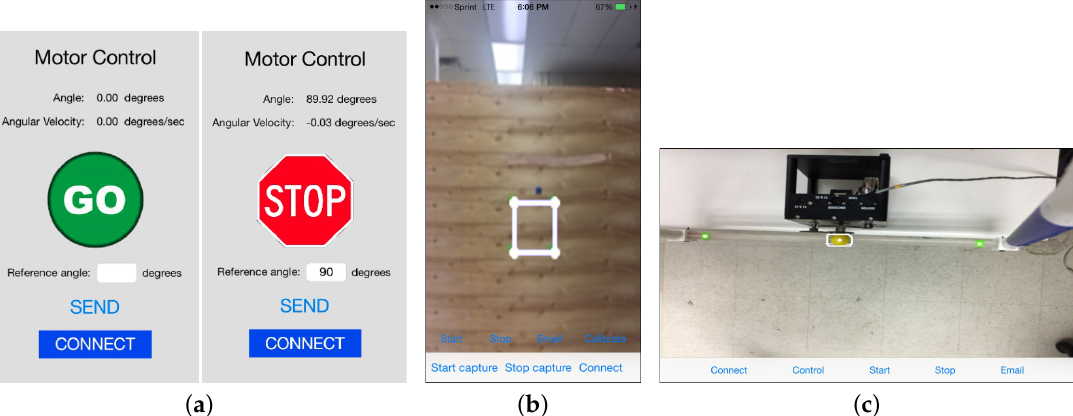
Figure 9. User interfaces for the ( a ) motor; ( b ) inverted pendulum; and ( c ) ball and beam